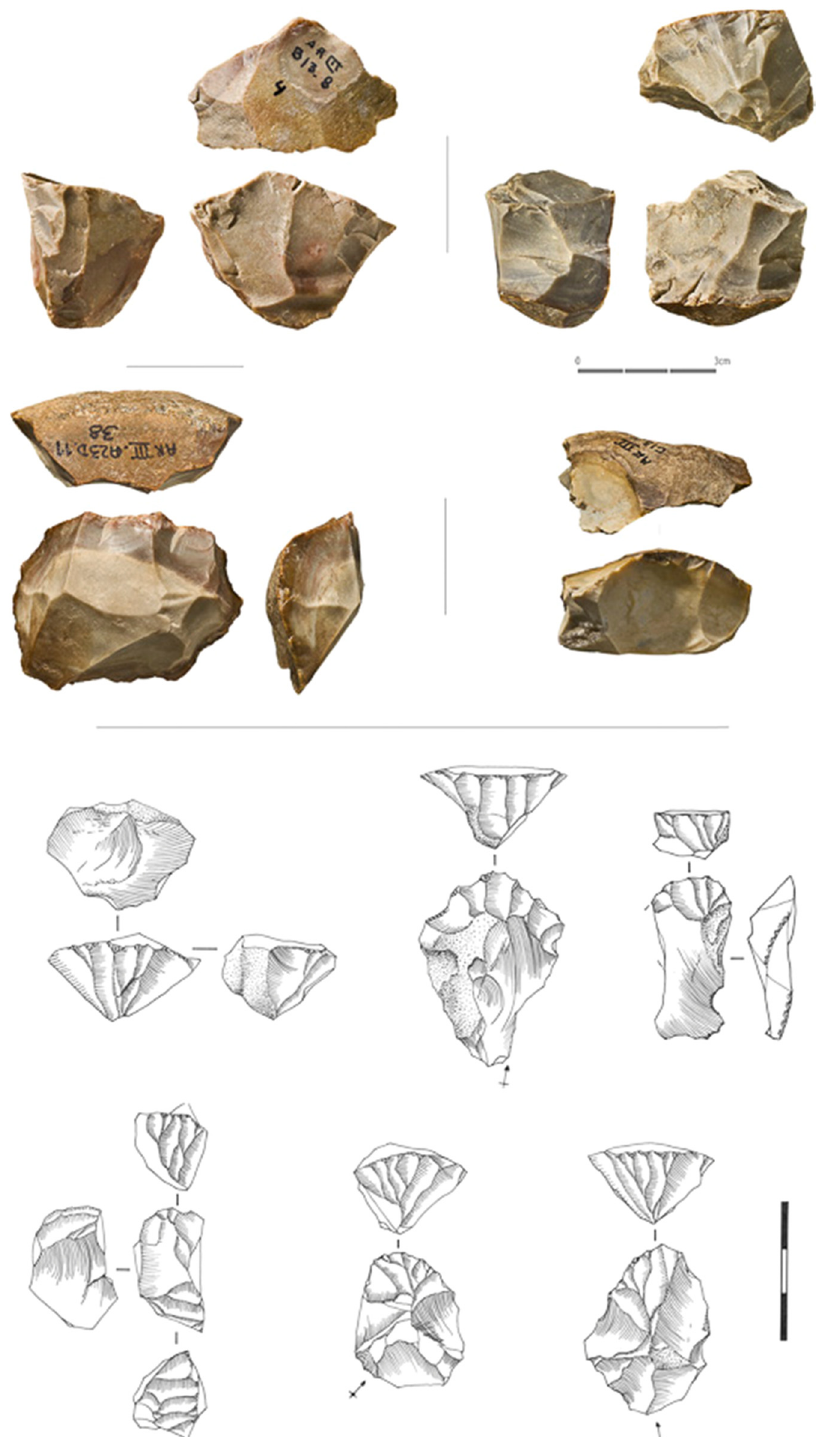
Figure 8: Areeiro 3: cores of carinated endscraper type from which blanks for the Areeiro armatures were produced. Photo, J. P. Ruas; drawing, F.